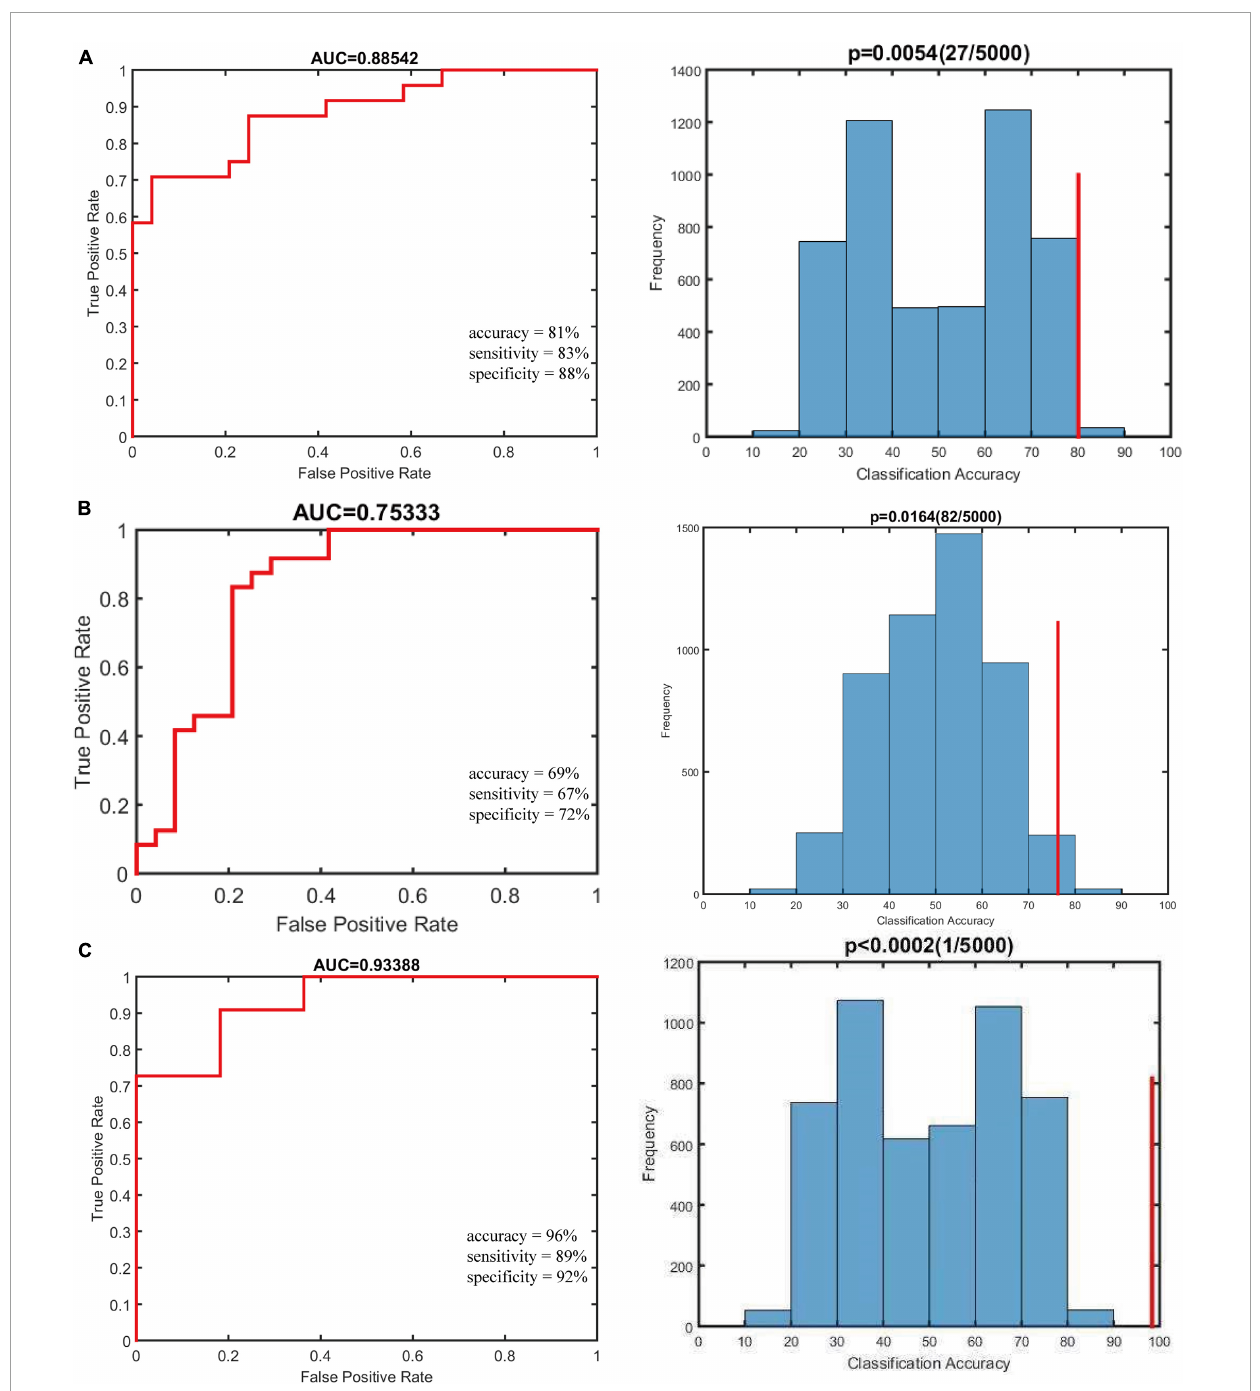
FIGURE3 Results of classification analyses. Null distribution on the permutation test (indicated by the histogram) and the actual classification accuracy (indicated by the red vertical line). The P -value is shown at the top of the life figure. (A) The classification using altered dynamic amplitude of low-frequency fluctuation (dALFF) variability achieved an accuracy of 81%, sensitivity of 83%, and specificity of 88%. (B) The classification using altered static amplitude of low-frequency fluctuation (sALFF) achieved an accuracy of 69%, sensitivity of 67%, and specificity of 72%. (C) The classification using combination of two features achieved an accuracy of 96%, sensitivity of 89%, specificity of 92%, and the area under curve (AUC) of classification was 0.93.